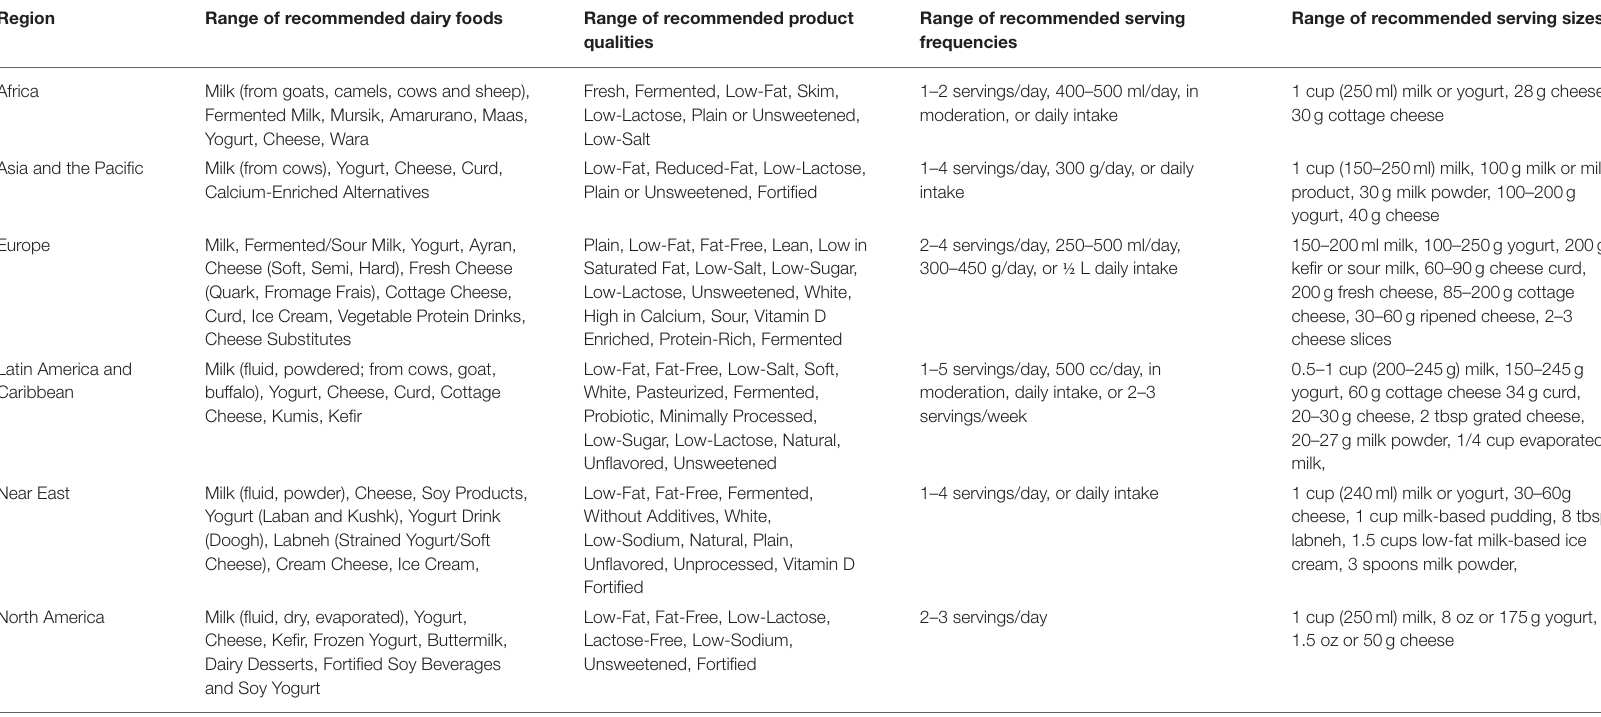
TABLE 1 | Regional trends in dairy food recommendations in food-based dietary